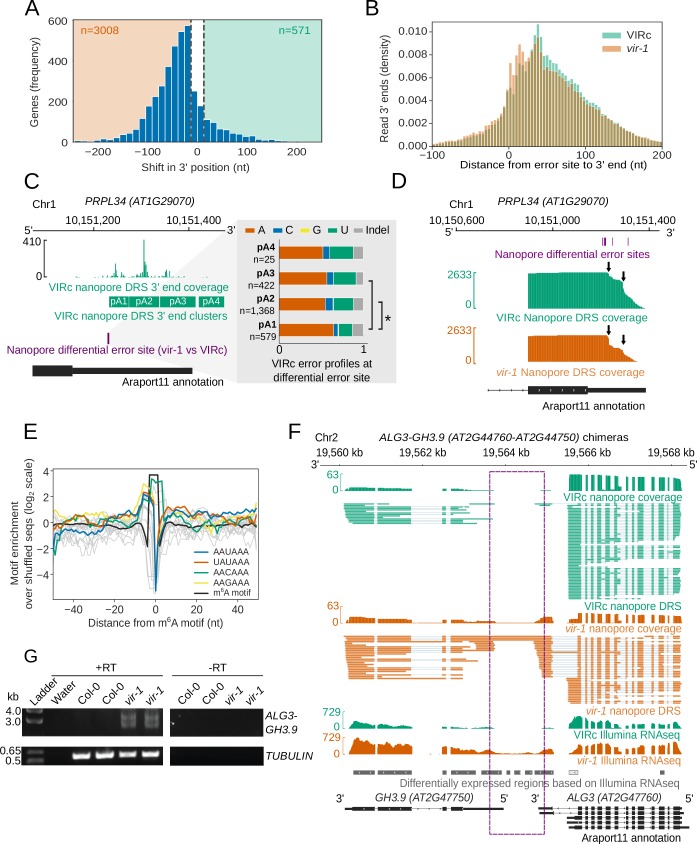
RNA methylation is closely linked to poly(A) site selection.(A) Global shift to proximal 3′ end usage observed in the vir-1 mutant compared with the VIRc line. Histogram showing the distance in nucleotides between the most reduced and most increased 3′ end positions for genes in which the 3′ end profile is altered in vir-1 (detected with the Kolmogorov–Smirnov test, FDR < 0.05). A threshold of 13 nt was used to detect changes in the 3′ end position. (B) A shift to the use of more proximal poly(A) sites is observed in m6A containing transcripts in the vir-1 mutant. Histogram showing distance from the error site (n = 17,491 error sites) to upstream and downstream 3′ ends: orange, vir-1; green, VIRc. (C) Poly(A) site choice is phased with m6A at PRPL34 (AT1G29070). PRPL34 has four distinct poly(A) site clusters identified from VIRc reads. Analysis of the error profiles of these clusters at the closest upstream m6A motif indicates that proximally polyadenylated isoforms are less likely to be methylated. Green, VIRc 3’ coverage and poly(A) clusters; purple, nanopore differential error site tested; black, Araport11 annotation. Zoomed view shows stacked barplots of VIRc error profiles for the tested nanopore differential error site. Pairs of clusters with significantly different profiles (G-test, FDR < 0.05) are indicated with asterisks. (D) PRPL34, which is methylated in at least two positions in the 3’UTR (Figure 5F), also displays an increase in alternative polyadenylation at a proximal poly(A) site in the vir-1 mutant. The proximal poly(A) site is approximately 17 nt downstream of the closest methylated position. Purple, nanopore differential error sites; green, VIRc coverage; orange, vir-1 coverage; black, Araport11 annotation. (E) RNA methylation sites overlap with canonical and degenerate poly(A) site motifs. Line plot showing the enrichment of poly(A) site motifs (with an edit distance of one) around m6A motifs detected de novo under nanopore differential error sites: blue, the canonical PAS motif AAUAAA; grey, other similar motifs (excluding AAAAAA); orange, the UAUAAA motif; green, the AACAAA motif; yellow, the AAGAAA motif; black, the m6A motif (includes all sequences shown in Figure 5—figure supplement 1E). (F) Readthough events and chimeric RNAs are detected in vir-1. Green, nanopore DRS and Illumina RNAseq data for the VIRc line; orange, nanopore DRS and Illumina RNAseq data for the vir-1 mutant; grey and white, differentially expressed regions between vir-1 and VIRc detected using Illumina RNAseq data with DERfinder that are upregulated and downregulated, respectively; black, Araport11 annotation. Intergenic readthrough regions are highlighted by the purple dashed rectangle. (G) ALG3-GH3.9 chimeric RNAs transcribed in the vir-1 mutant. Chimeric readthrough RNAs were validated using RT-PCR. RT-PCR products were separated on agarose gel and stained with SYBR Safe. RT+ and RT-, cDNA produced in the presence and absence of reverse transcriptase, respectively; ladder, DNA size ladder; Water, no template control. TUBULIN was used as a control.Figure 7—source data 1.Differential poly(A) site choice results for vir-1 vs VIRc, derived from nanopore 3’ ends – Figure 7A.Figure 7—source data 2.vir-1 vs VIRc differentially expressed regions from Illumina RNAseq - Figure 7F.Figure 7—source data 3.Differential chimeric read results for vir-1 vs VIRc - Figure 7F.